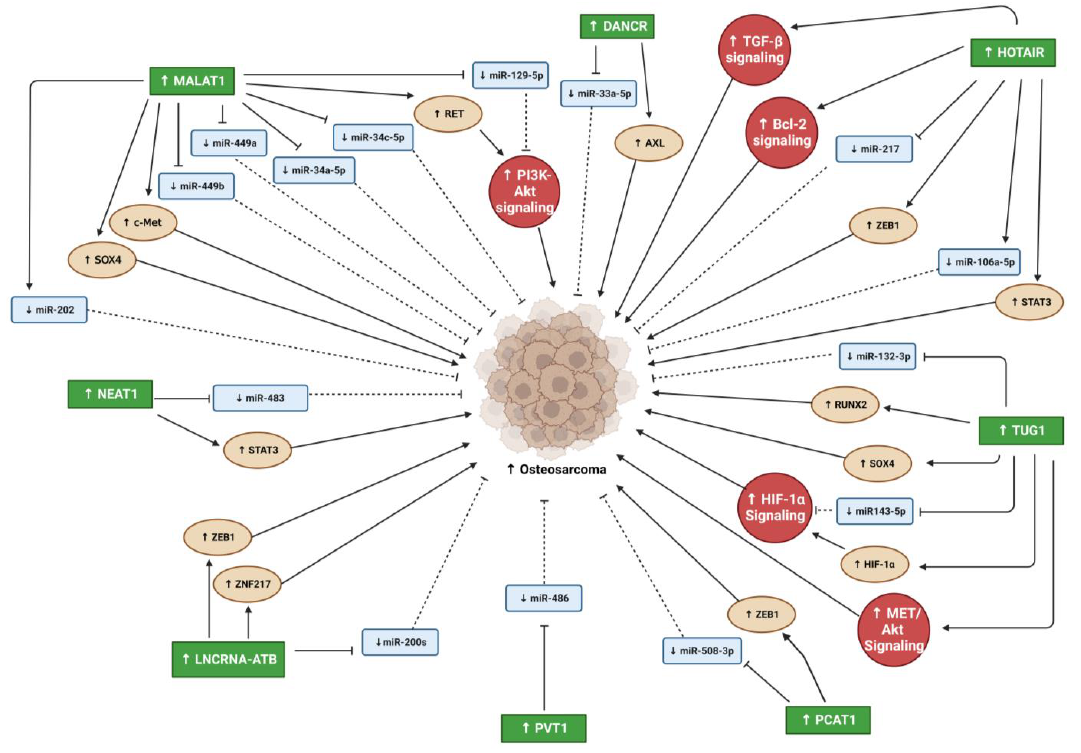
Figure 3. Summary lncRNAs oncogenic effects that promote OS progression. Blunt arrows ( ┴ ) indicate inhibition while sharp arrows ( → ) indicate stimulation. Solid lines denoted direct interaction; interrupted lines denoted indirect interaction.